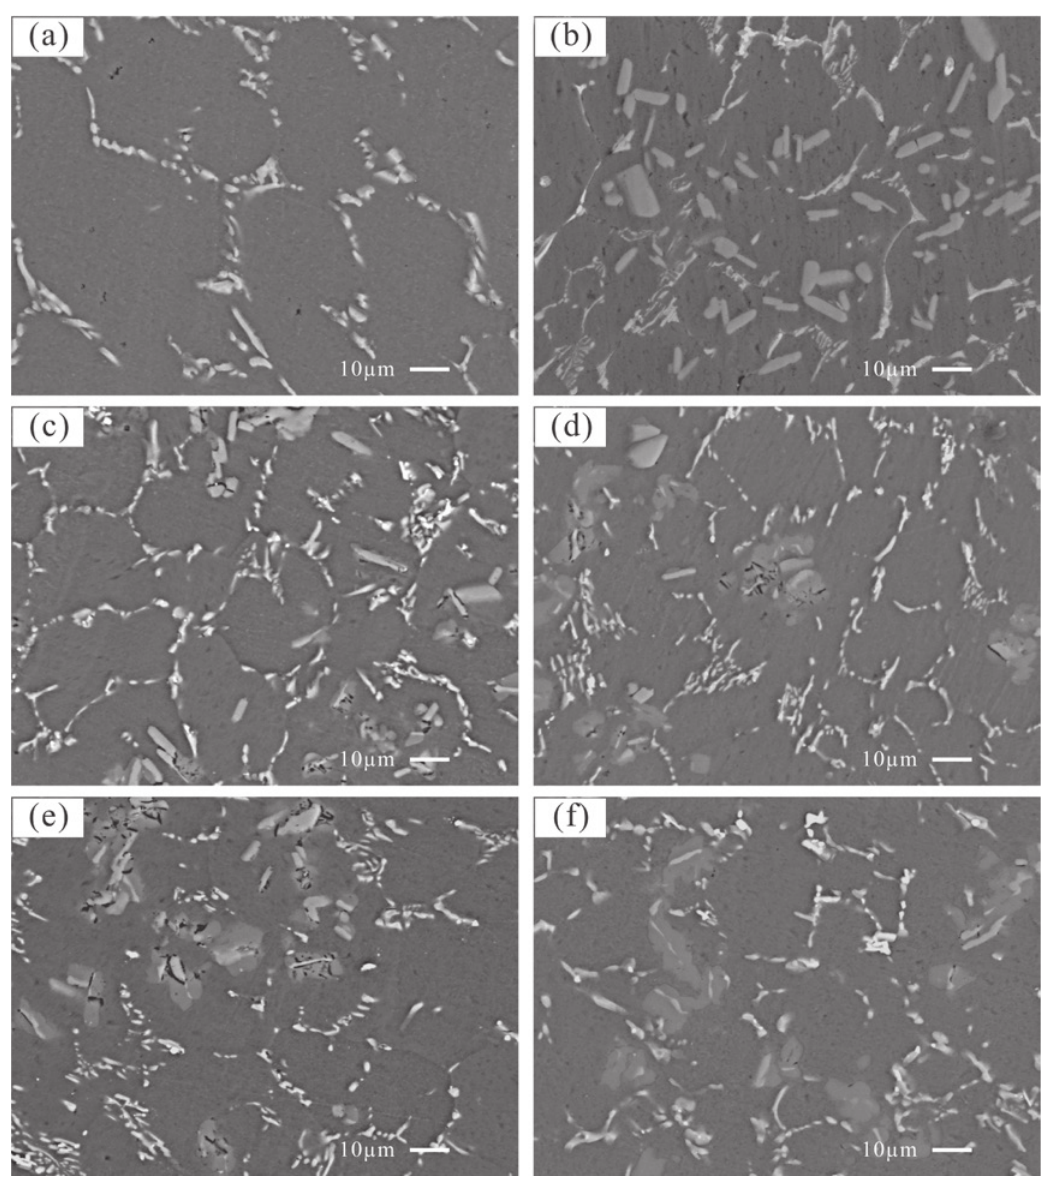
Fig. 5: BSE images of alloy 2618 homogenized at 773 K for 12 h (a) and Ti-containing alloy 2618 homogenized at 773 K for different times: (b) 0 h; (c) 8 h; (d) 12 h; (e) 16 h; (f) 24